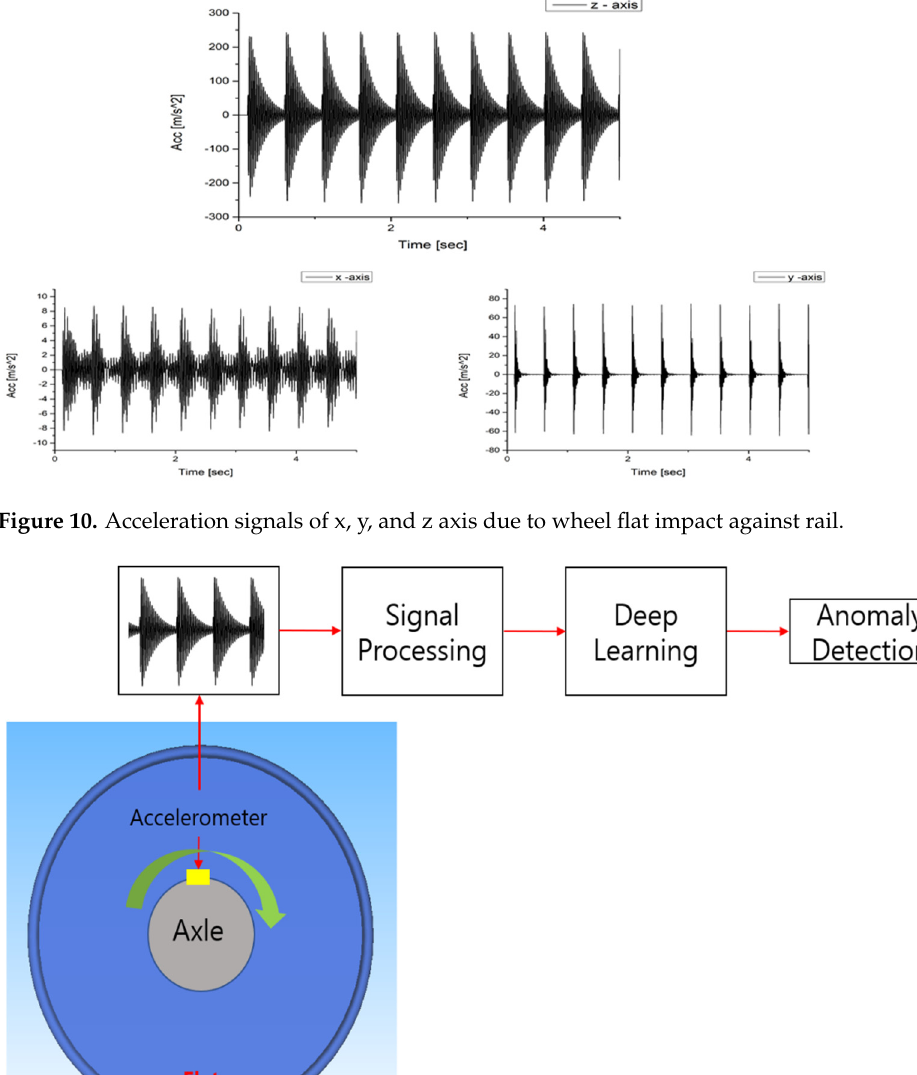
Figure 9. Principle of wheel and rail collision by wheel flat [19].